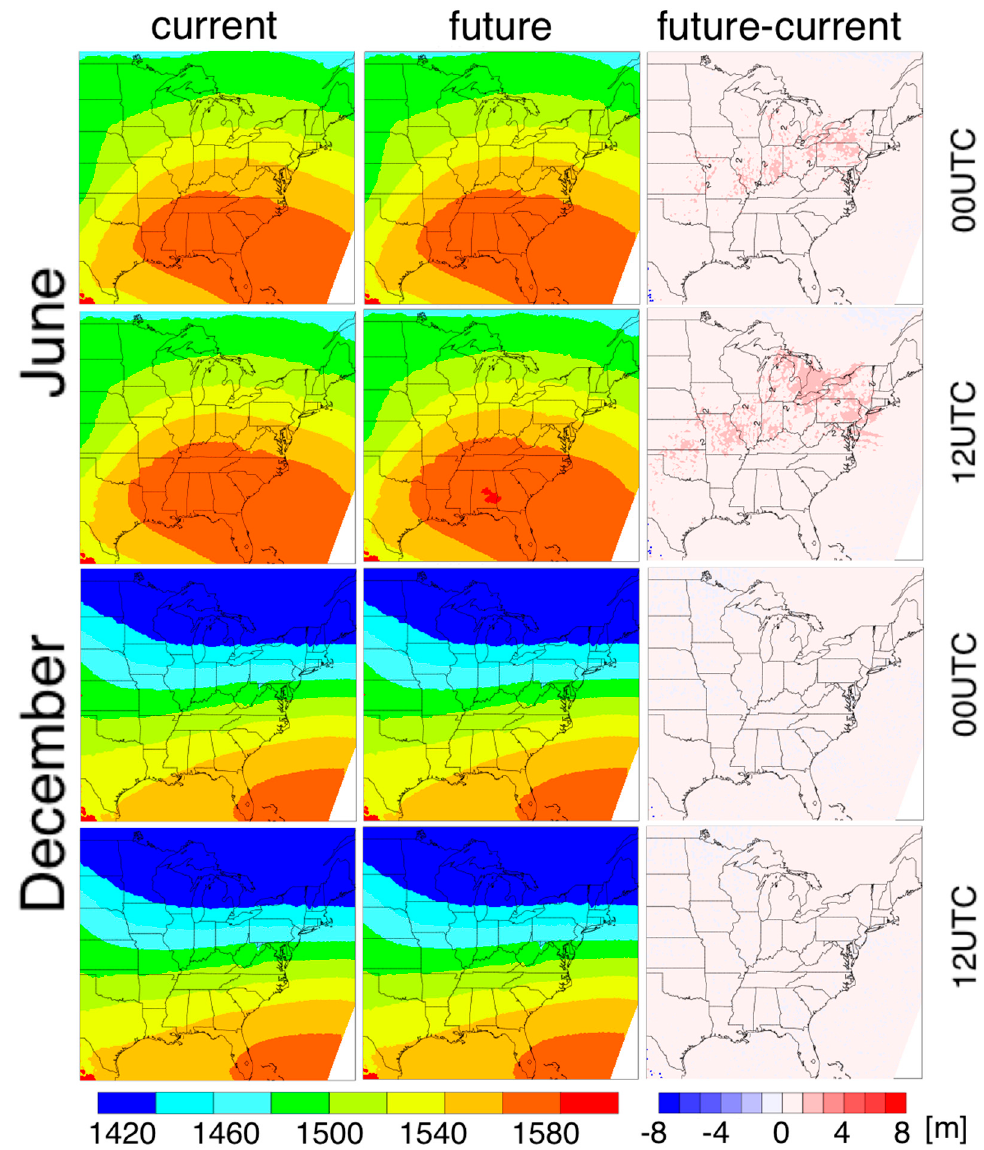
Figure 8. Same as Figure 6, but for geopotential height.